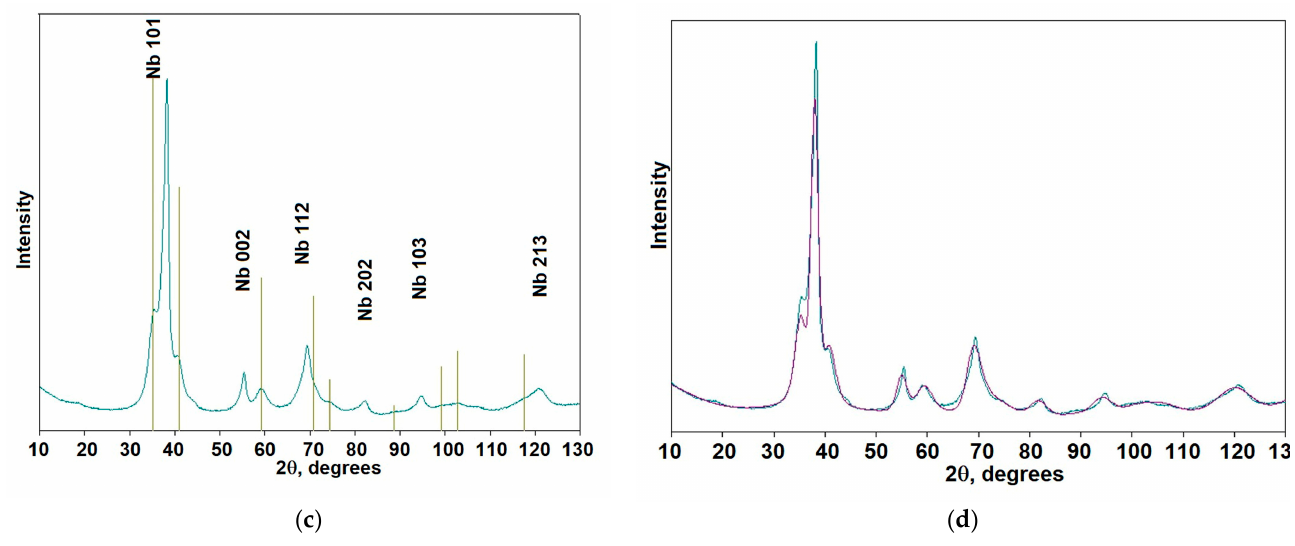
Figure 3. X-ray diffraction patterns of samples of the «niobium + nanodiamonds» composite after various processing times by mechanical alloying: ( a ) after 0.5 h (stick-diagram shows niobium hybrid NbH 0.86 ), ( b ) after 1.2 h (stick-diagram shows niobium carbide NbC), ( c ) after 6 h (stick-diagram shows niobium carbide NbC 0.77 ), ( d ) comparing the experimental X-ray diffraction pattern (painted green) with the fitted X-ray diffraction pattern (painted lilac) for the sample shown in Figure 3c.